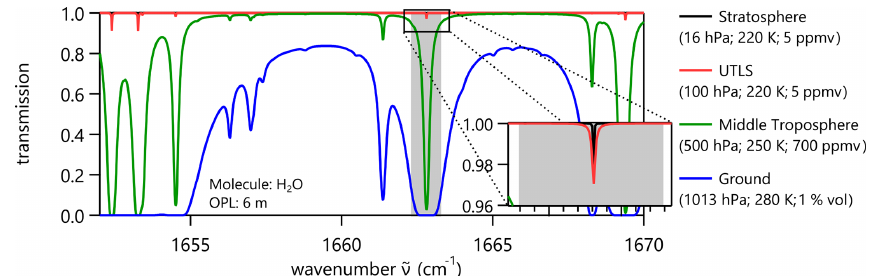
Figure 2. Simulated transmission spectra of H 2 O in the mid-IR (around 6µm) at several vertical locations of the atmosphere for an absorption path length of 6m. The selected absorption line is distinctly isolated such that the zero-absorption baseline remains accessible for a broad range of pressures and H 2 O concentrations. Its intensity is strong enough to ensure good SNR even at stratospheric conditions. The gray shading denotes the tuning range of the QCL.